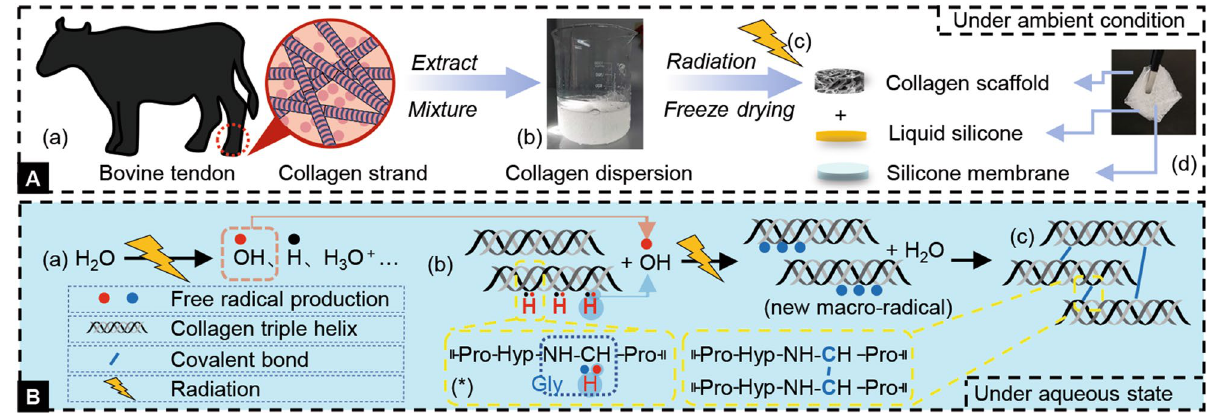
Figure 1. Schematic illustration of the preparation progress of radiation crosslinked bilayer collagen scaffold. ( A ) The preparation process of radiation crosslinked bilayer collagen scaffold. ( a ) Extraction. ( b ) Mixture. ( c ) Radiation. ( d ) Combination. ( B ) The proposed mechanisms of crosslinking for collagen under radiation. ( a ) Water radiolysis. ( b ) Chain-transfer. ( c ) Cross-linking. (*) Representative